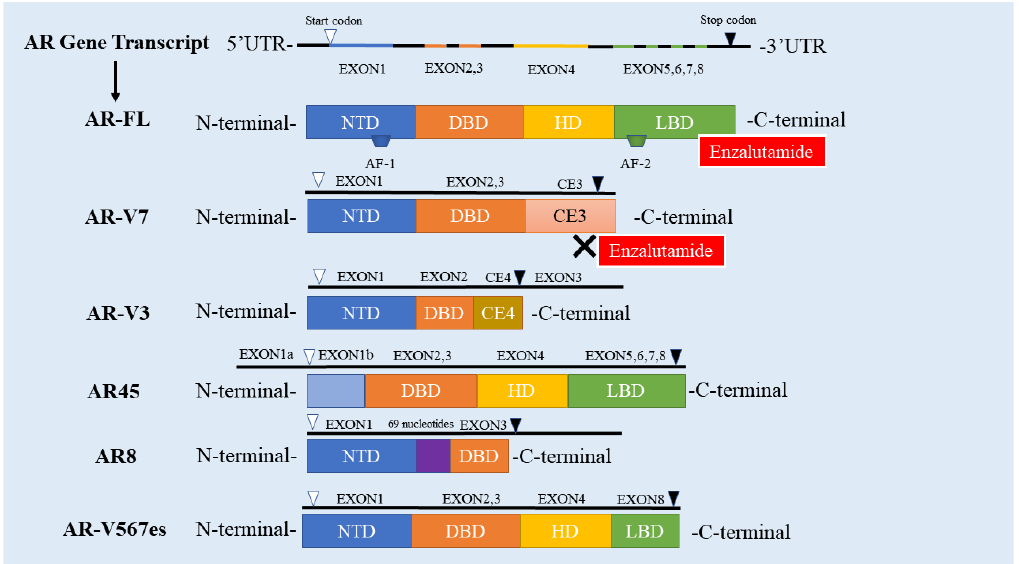
Figure 1. The Structure of AR-FL and AR-Vs. The human AR gene contains eight exons; AR has four domains, including NTD, DBD, HD and LBD. Exon 1 encodes NTD, DBD is encoded by exons 2 and 3, exon 4 encodes HD, and LBD is encoded by exons 5,6,78; AR-V7 has no LBD, so enzalutamide cannot bind to AR-V7; The DBD domain of AR-V3 is only encoded by exon 2, and lacks zinc finger; AR45 starts coding from exon 1b and lacks the NTD domain; The DBD domain formed by AR8 is only encoded by exon 3 and is not functional. AR8 inserts 69 nucleotides upstream of exon 3; AR-V567es does not contain exon 5.6.7; UTR: Untranslated Region; AR-FL: full-length androgen receptor; AR-V: androgen receptor splicing variant; NTD: N-end domain; DBD: DNA binding; HD: hinge domain; LBD: ligand binding domain; CE3: recessive exon 3; AF: Activate the